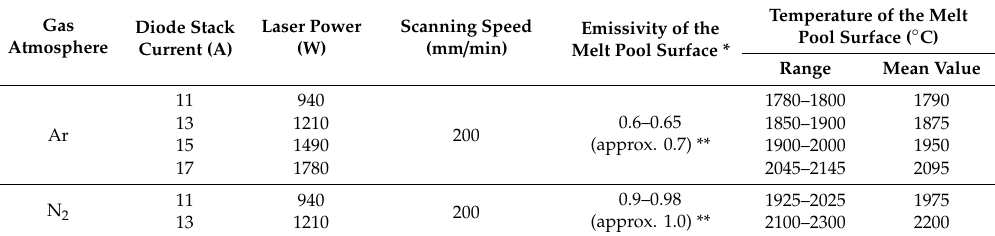
Figure 13. Results of temperature measurements on the surface of a melt pool obtained by the non-standardized thermocouple W-Mo and the pyrometer IMPAC IS 140 at di ff erent HPDDL output power of nitriding the Ti6Al4V substrate in pure nitrogen atmosphere. For comparison, the results of pyrometric measurements were determined for di ff erent value of the normal spectral emissivity. Table 2. Influence of laser output power of diode laser ROFIN DL 020, emitting at 808–960 nm wavelength, on the temperature of the melt pool surface during laser melting of the titanium alloy Ti6Al4V sheet, 3.0 mm thick in argon atmosphere and during laser nitriding, determined by infrared pyrometer IMPAC IS140 with a spectral range 0.7–1.1 µ